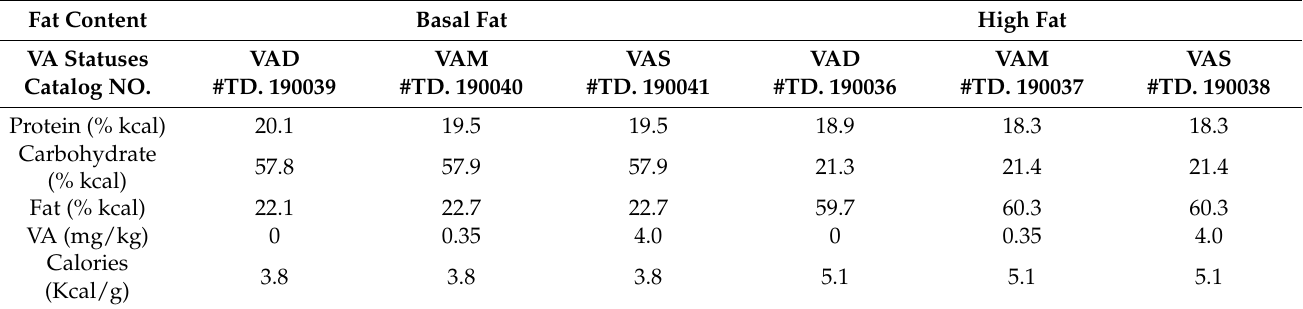
Table 1. Protein, carbohydrate, fat, VA and caloric content of each diet used in the study. Basal Fat High